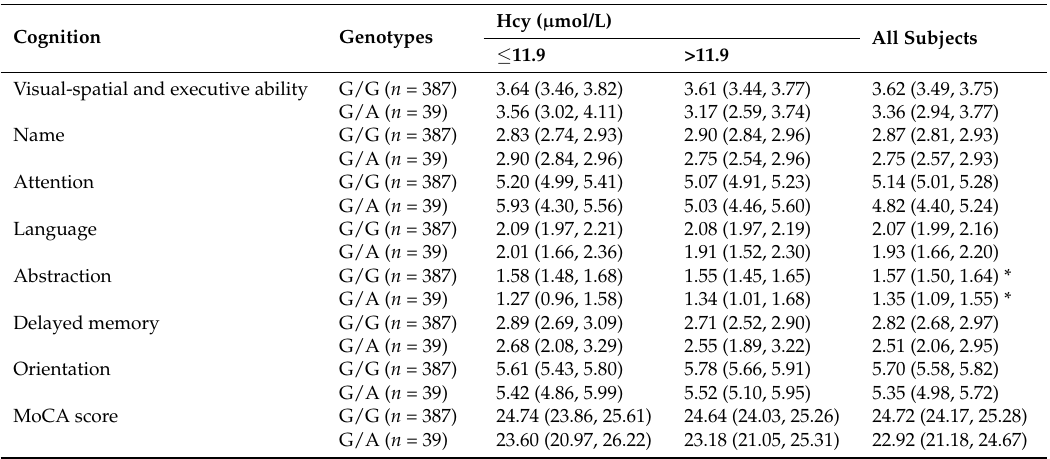
Table 7. MoCA scores by serum Hcy level and MTHFR G1793A genotypes.